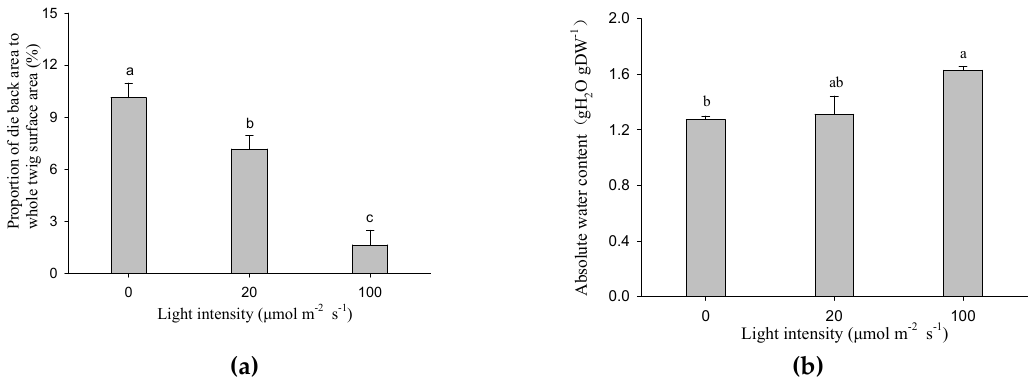
Figure 3. Die back proportion ( a ) and absolute water content ( b ) of the twigs exposed to different light intensities. Data were mean ± SE with n = 3. The different lowercase letters above the column indicate the significant ( p < 0.05) difference between light intensity treatments.